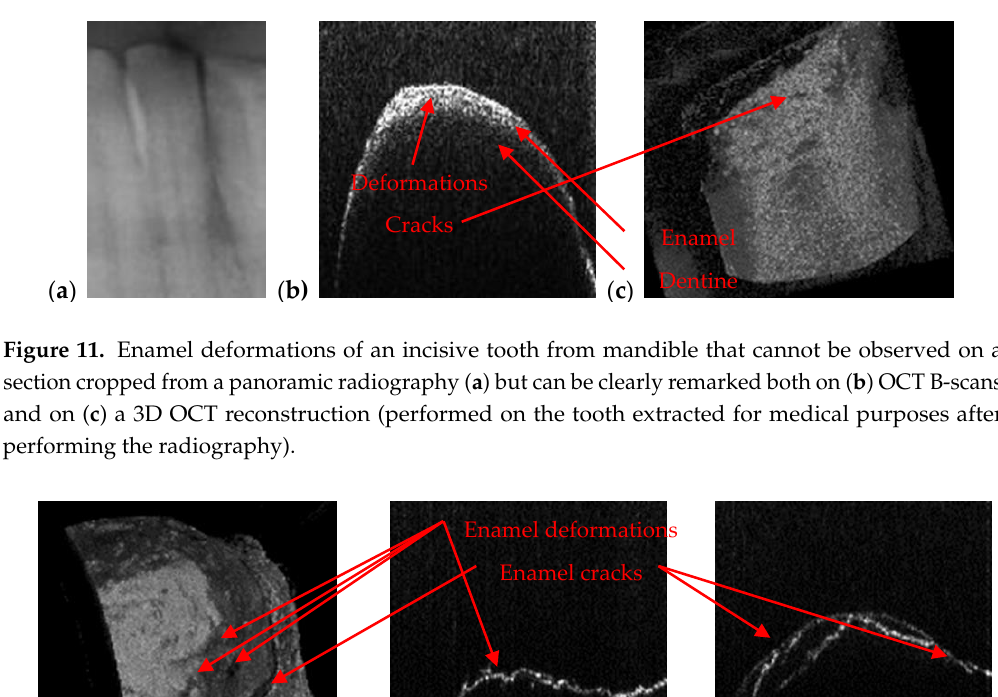
Figure 13. OCT used to check the adaptation of metallic cape on the tooth: ( a ) photo of the tooth with cape, ( b ) OCT B-scan showing both the tooth and the metallic cape, ( c ) 3D reconstruction, and ( d ) section cropped from a panoramic radiography. Patient S.S., female, age 57 years, diagnosed with multiple abscessed teeth and periodontitis. In Figure 14a, a deep crack in a tooth is imaged. While the crack can be observed visually, in Figure 14a its depth can be assessed quantitatively using OCT images, choosing the appropriate B- scan, Figure 14c, from the 3D OCT reconstruction of the zone of interest, Figure 14b.